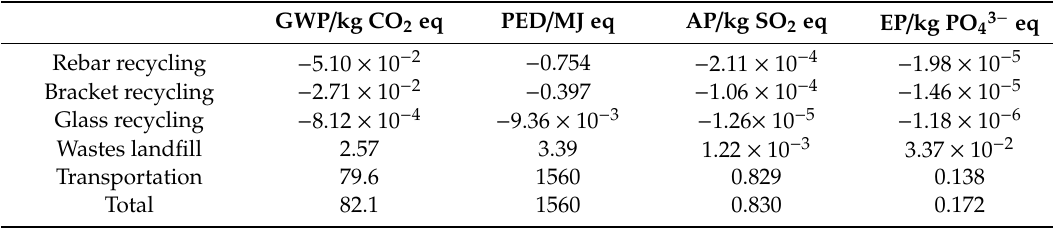
Table 2. Life-cycle impact results of the system disassembling and recycling